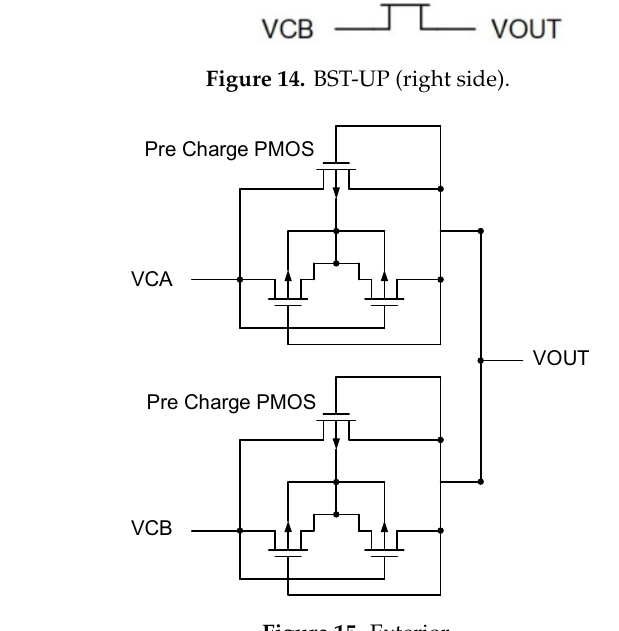
Figure 15. Exterior.